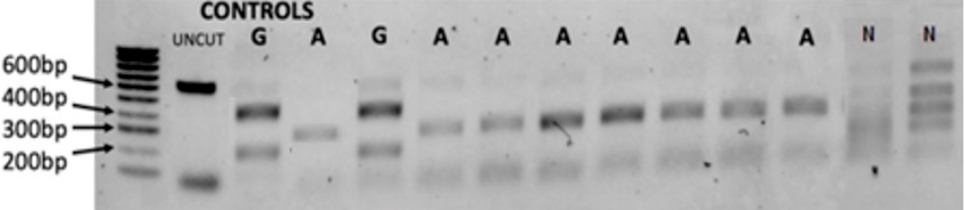
Figure 3. Gel images of the RFLP assay that shows typical PCR-RFLP variation profile.